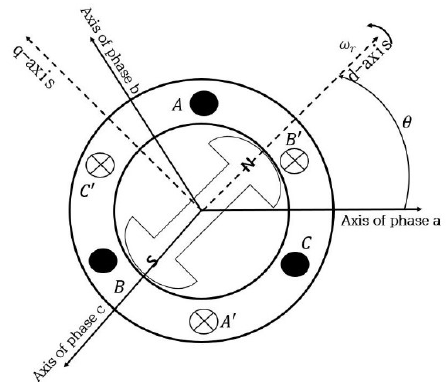
Figure 4. Schematic diagram of the Permanent Magnet Synchronous Generator.